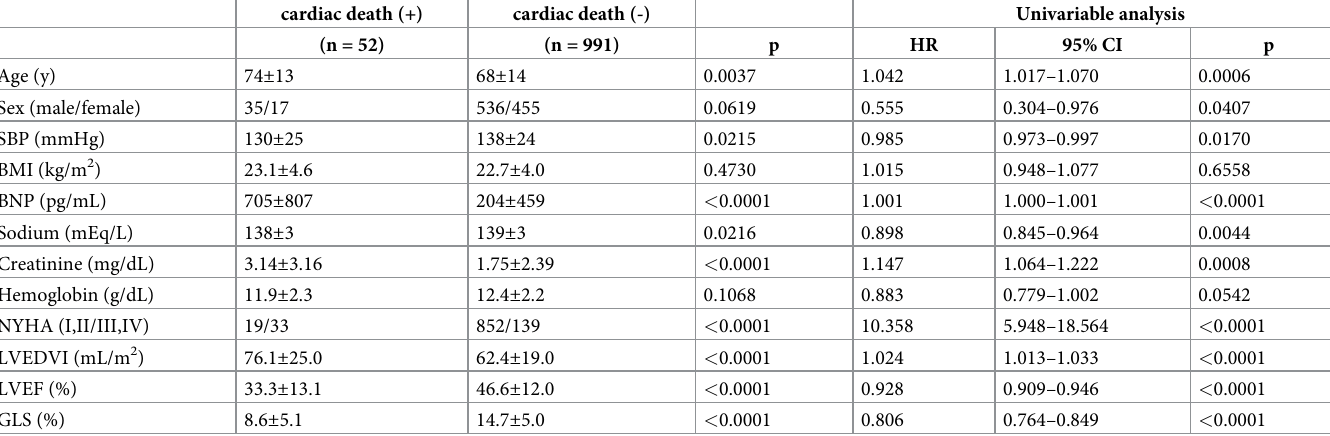
Table 2. Univariable cox proportional analyses for cardiac death in the derivation group.